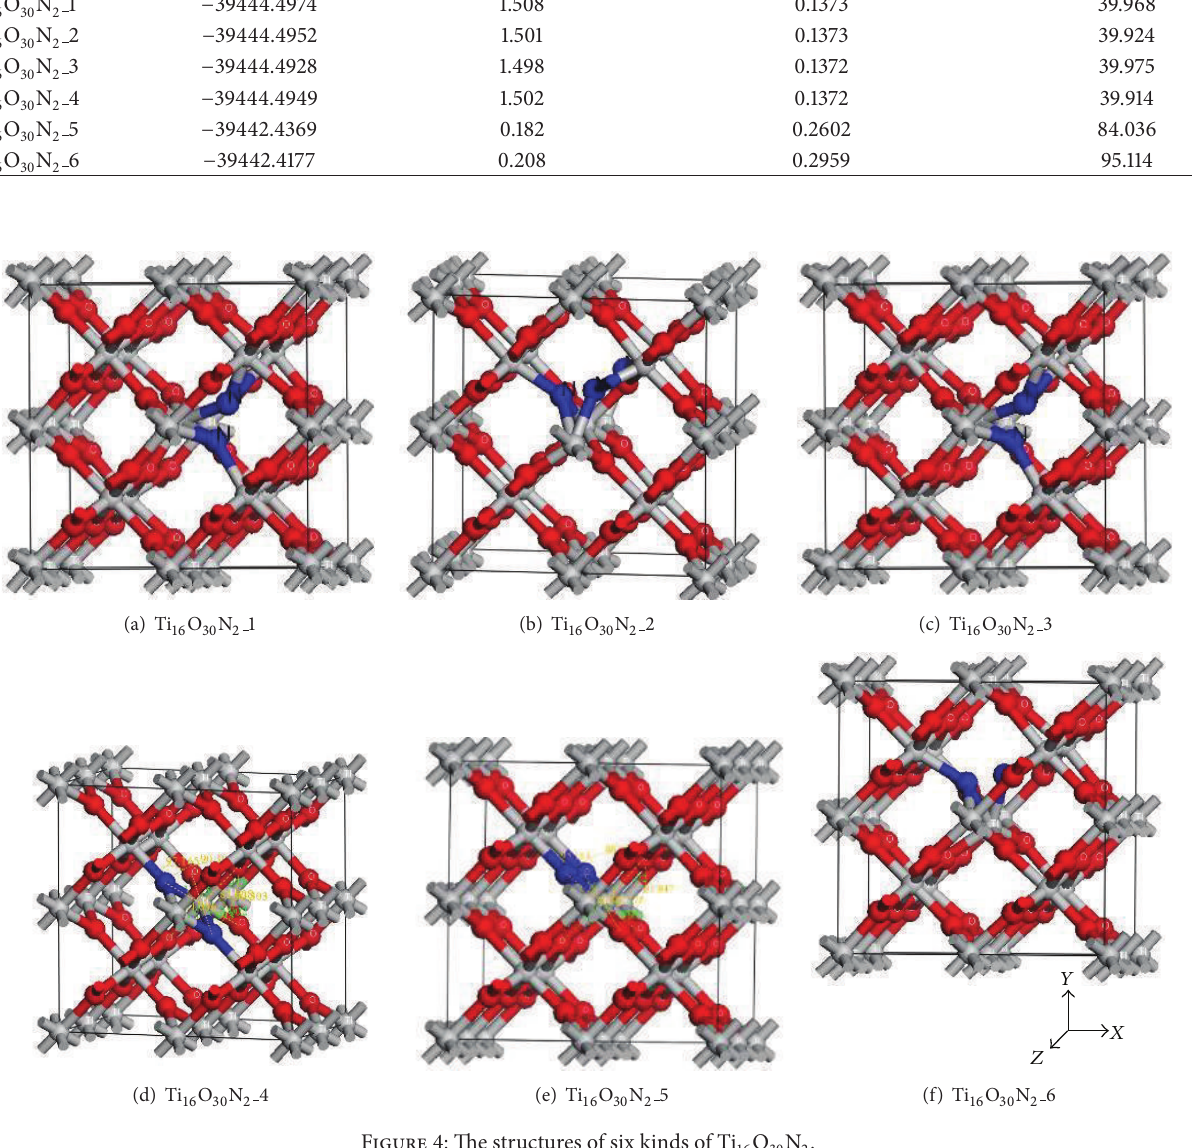
and the bond distance between the two doped N–N 2